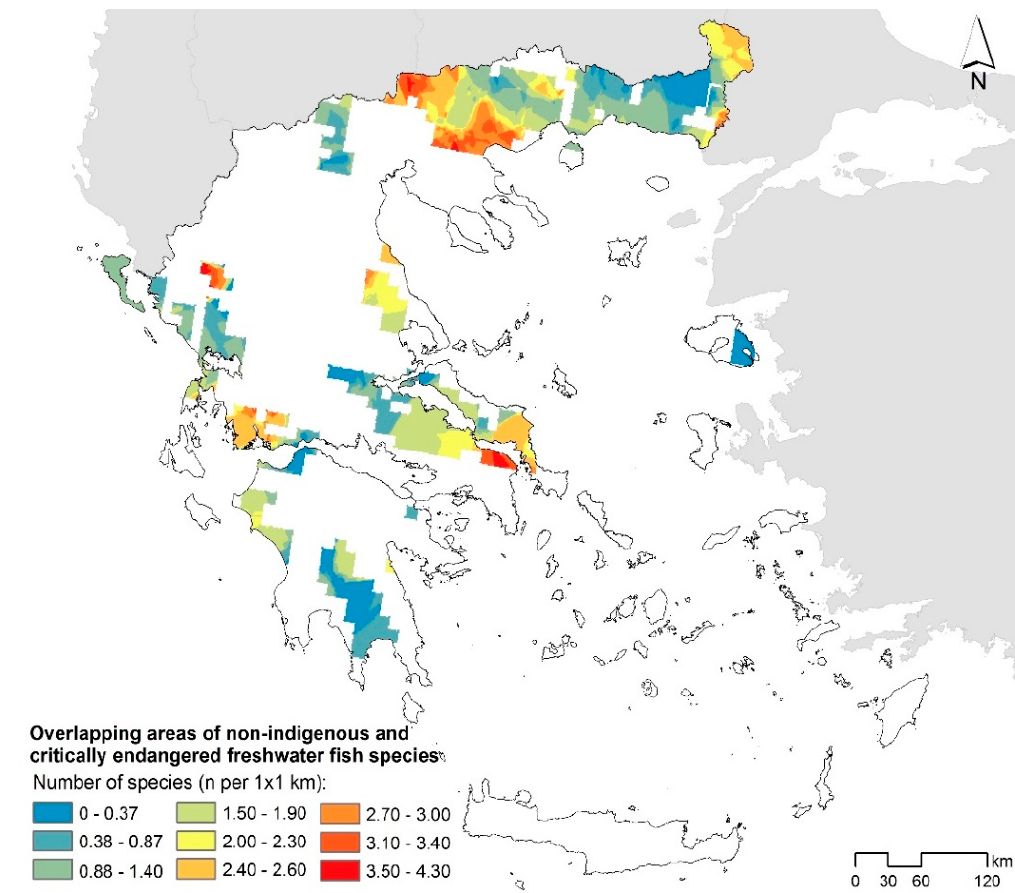
Figure 5. Overlapping areas between the distributions of NIFS and critically endangered freshwater fish species. A quarter of the overlapping areas (24.8%) fall well within the NATURA 2000 network (Figure 6a), where management bodies could implement control or mitigation programs to